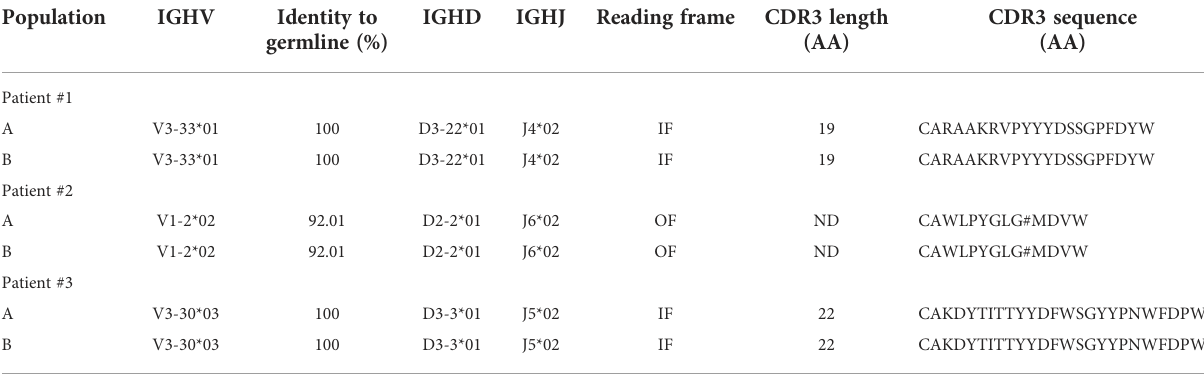
TABLE 1 IGHV clonality assessment of B-CLL healthy B cell subsets by CDR3 region sequencing.